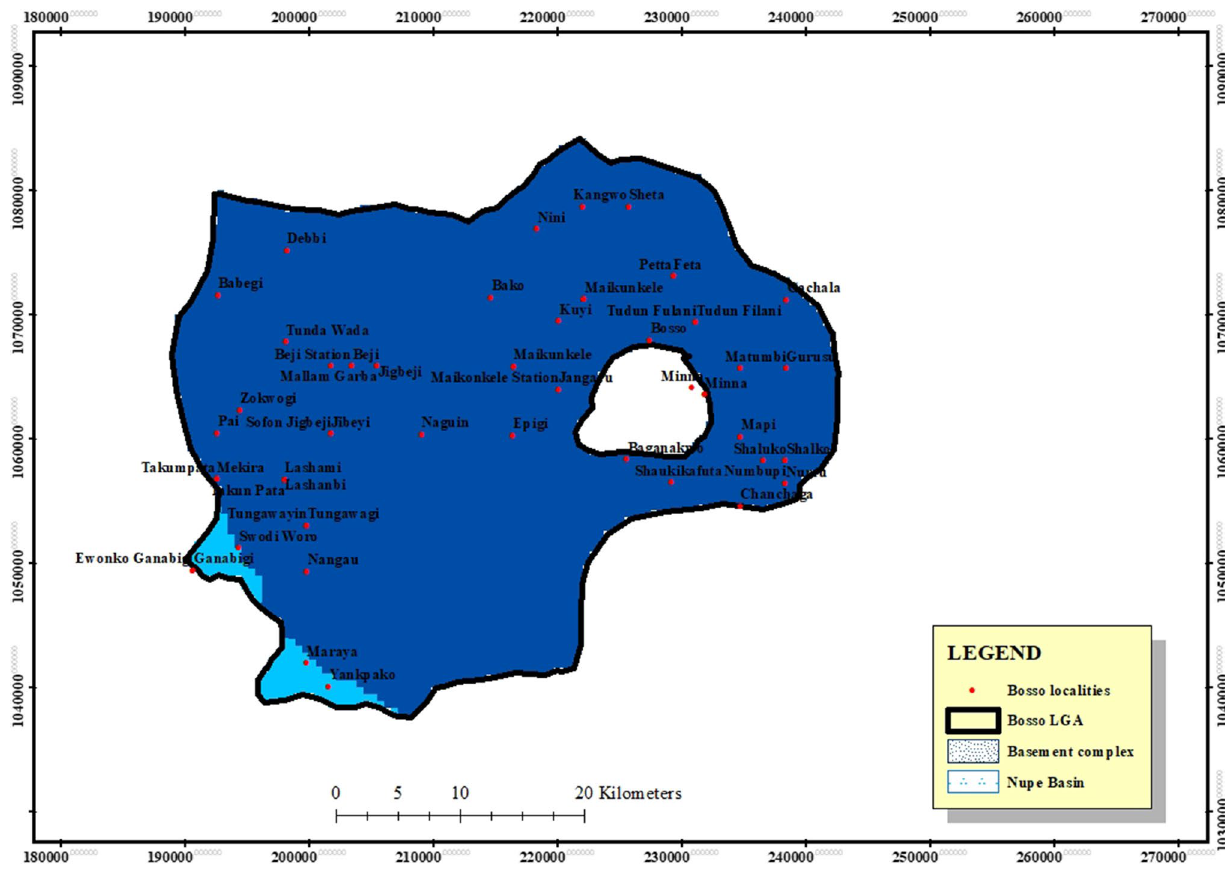
Fig. 3 Lithological units in the study